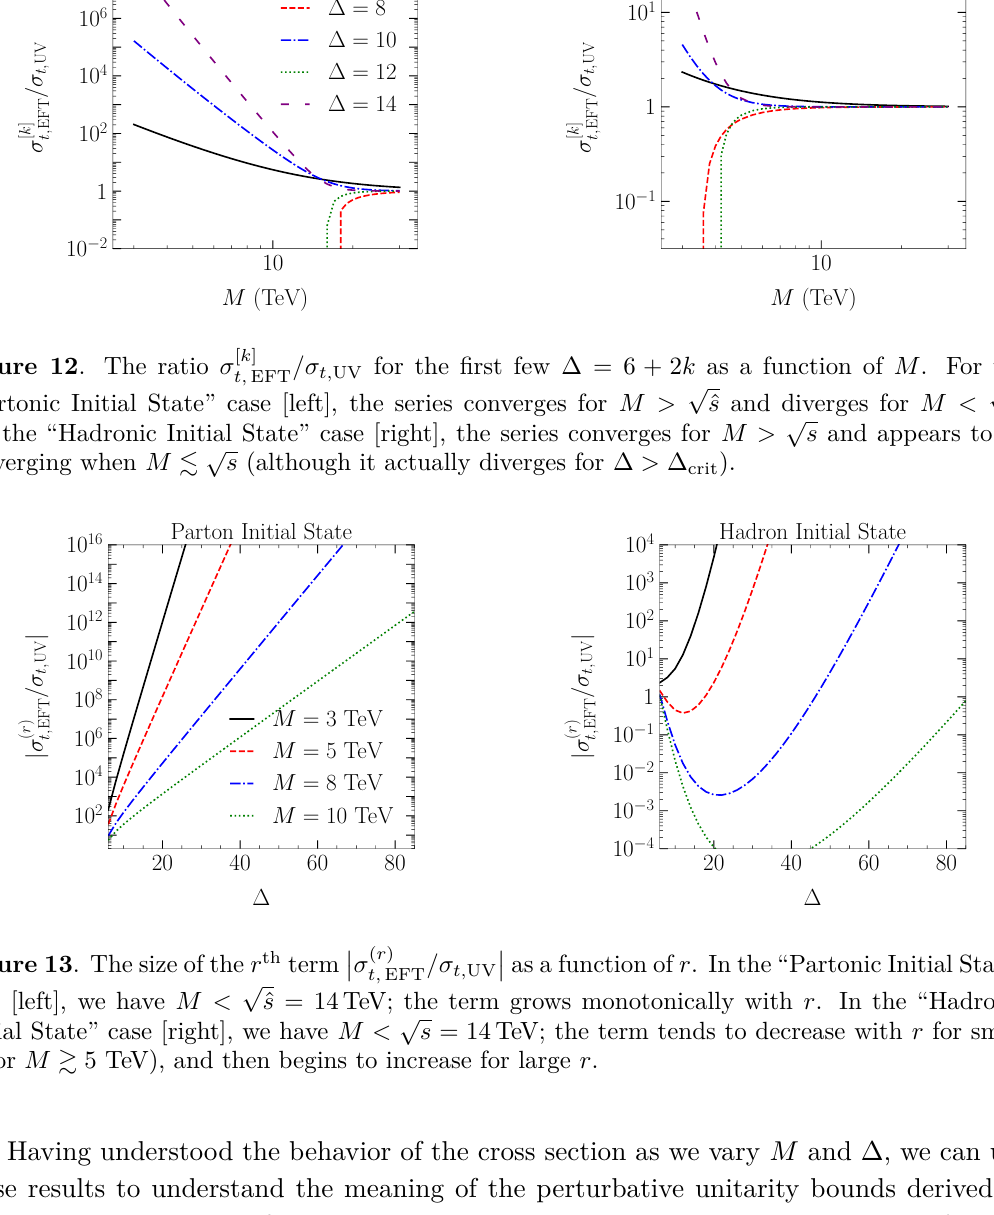
Figure 13 . The size of the r th term case [left], we have M < Initial State” case [right], we have M < r (for M & 5 TeV), and then begins to increase for large r